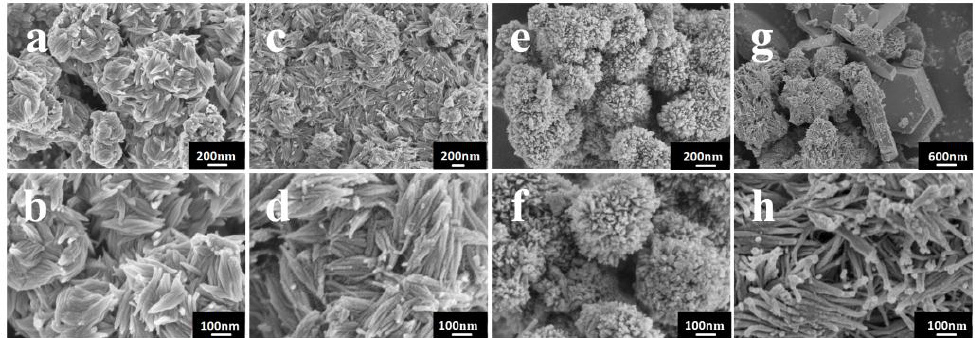
Figure 2. Scanning electron microscopy (SEM) images of the products prepared under different solvothermal reaction times: ( a , b ) 1 h; ( c , d ) 3 h; ( e , f ) 6 h; ( g , h ) 12 h.